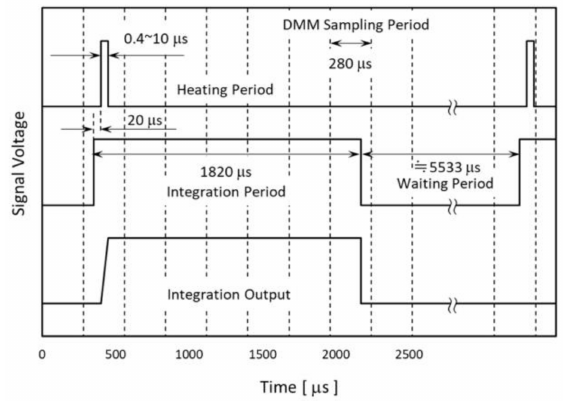
Figure 12. Timing chart of the detection